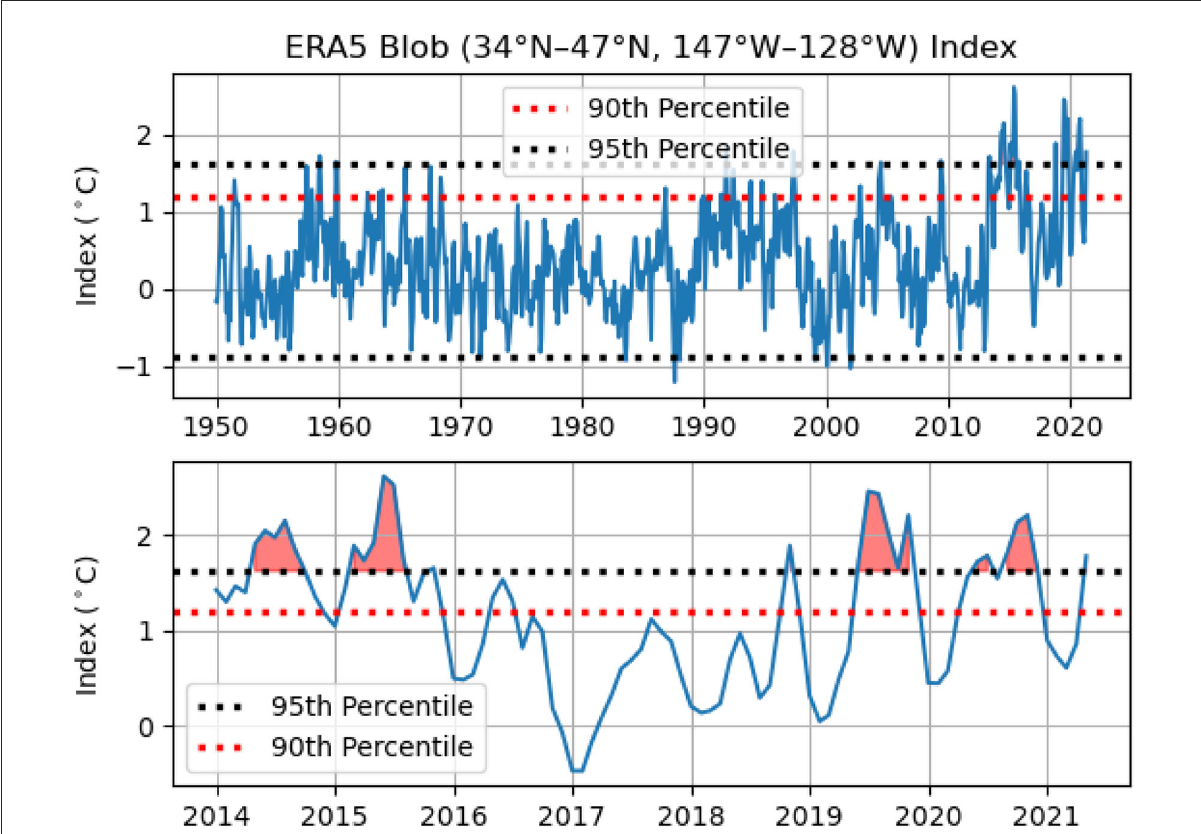
FIGURE14 The Blob index defined as the difference between the monthly average SST climatology (1981–2010) and the monthly average SST computed over the region 34 ◦ N-47 ◦ N and 147 ◦ W-128 ◦ W. We compute the Blob index from the monthly mean ERA5 SST data for the period January 1950-May 2021. We include the two-sided 95% confidence interval and the one-sided 90th percentile. The lower panel is the same Blob index with a focus on the period January 2014-May 2021 with the significant ocean warming events in 2014, 2015, 2019, and 2020